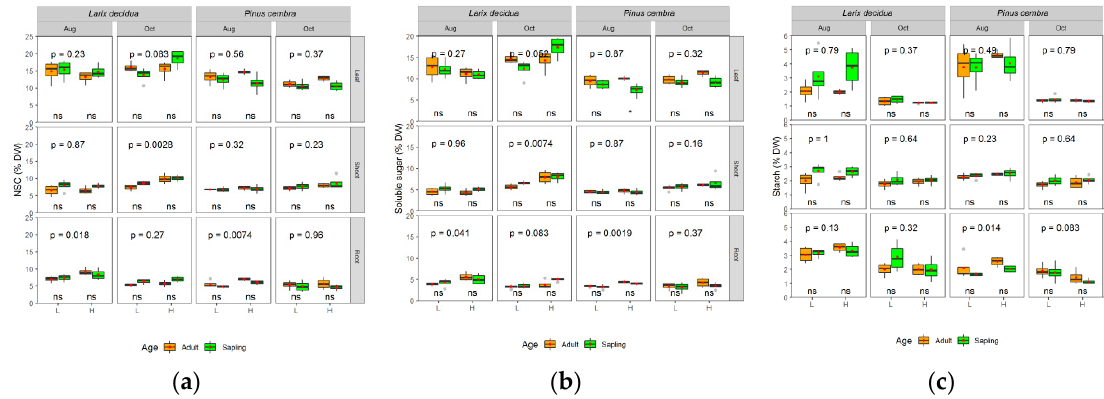
Figure 2. Non-structural carbohydrate concentration (% DW) ( a ), soluble sugar (% DW) ( b ), and starch (% DW) ( c ) (mean ± SE, n = 4) of different species ( Pinus cembra L. and Larix decidua Mill.), age (sapling and adult tree), altitude (L for timberline and H for treeline), season (Aug for mid-growing season and October for late season) and tissues (current-year leaf, shoot, and fine root). Asterisks or “ns” at the bottom of subplot indicate significant ( p < 0.05) or non-significant ( p > 0.05) differences between saplings and adults within the same altitude and season, and the p -value at the top of subplot denote significance level by the Wilcoxon’s mean test between L and H. The red points in the subplot denote mean value and grey point for outlier.